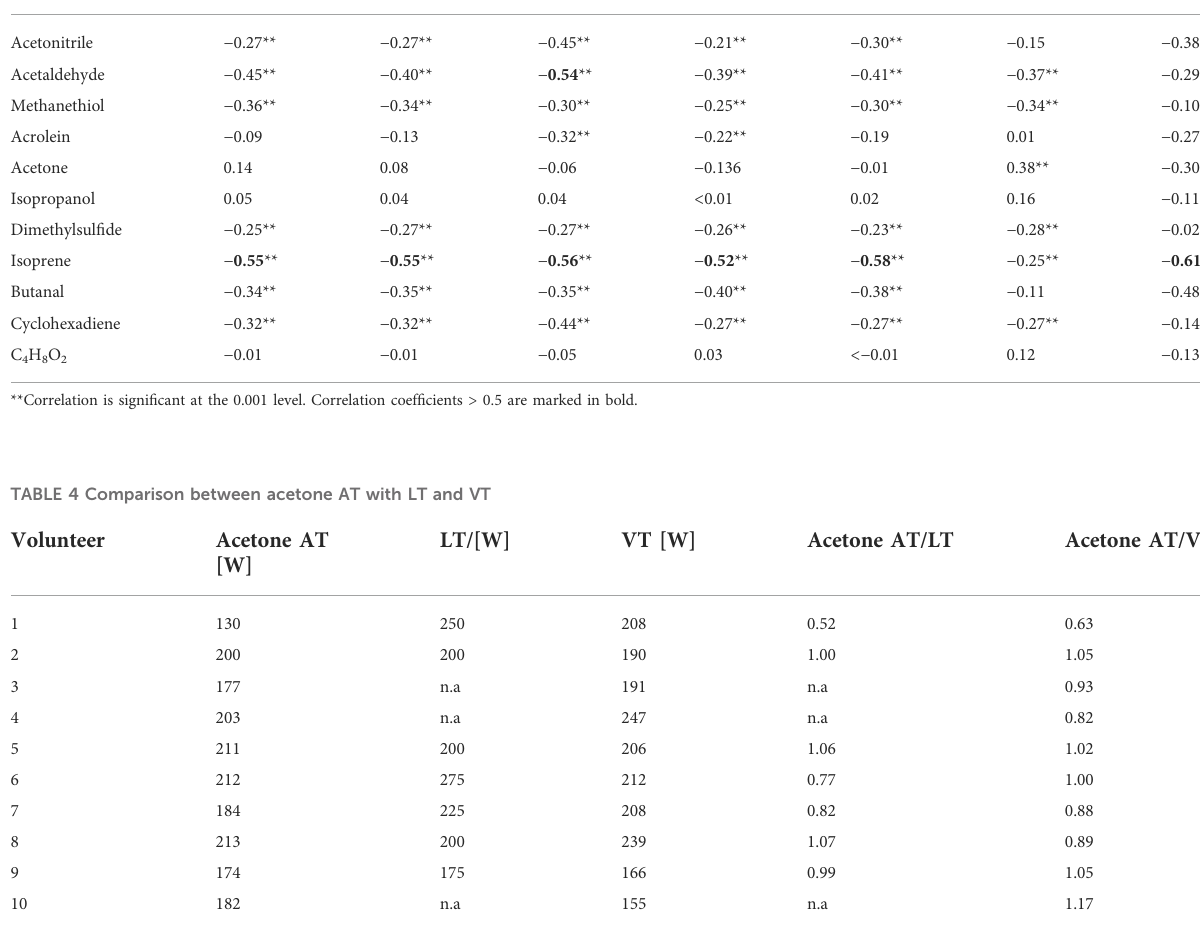
TABLE 3 Pearson product correlation coef fi cients between VOCs, spirometric parameters and HR. VOCs